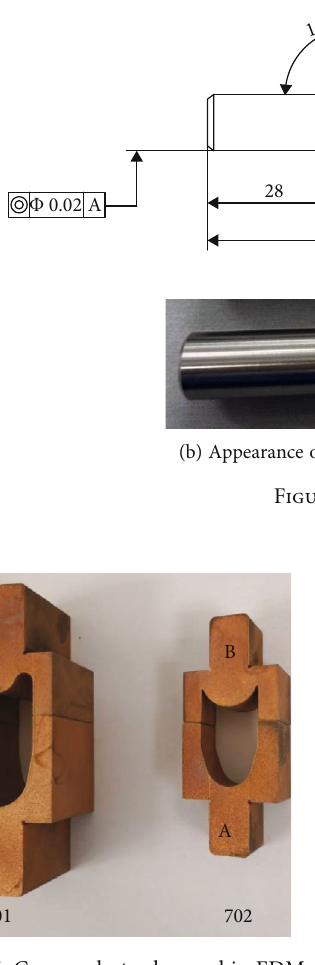
Figure 6: Copper electrodes used in